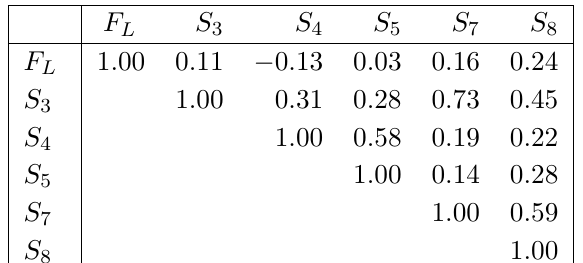
Statistical correlation matrix for the F